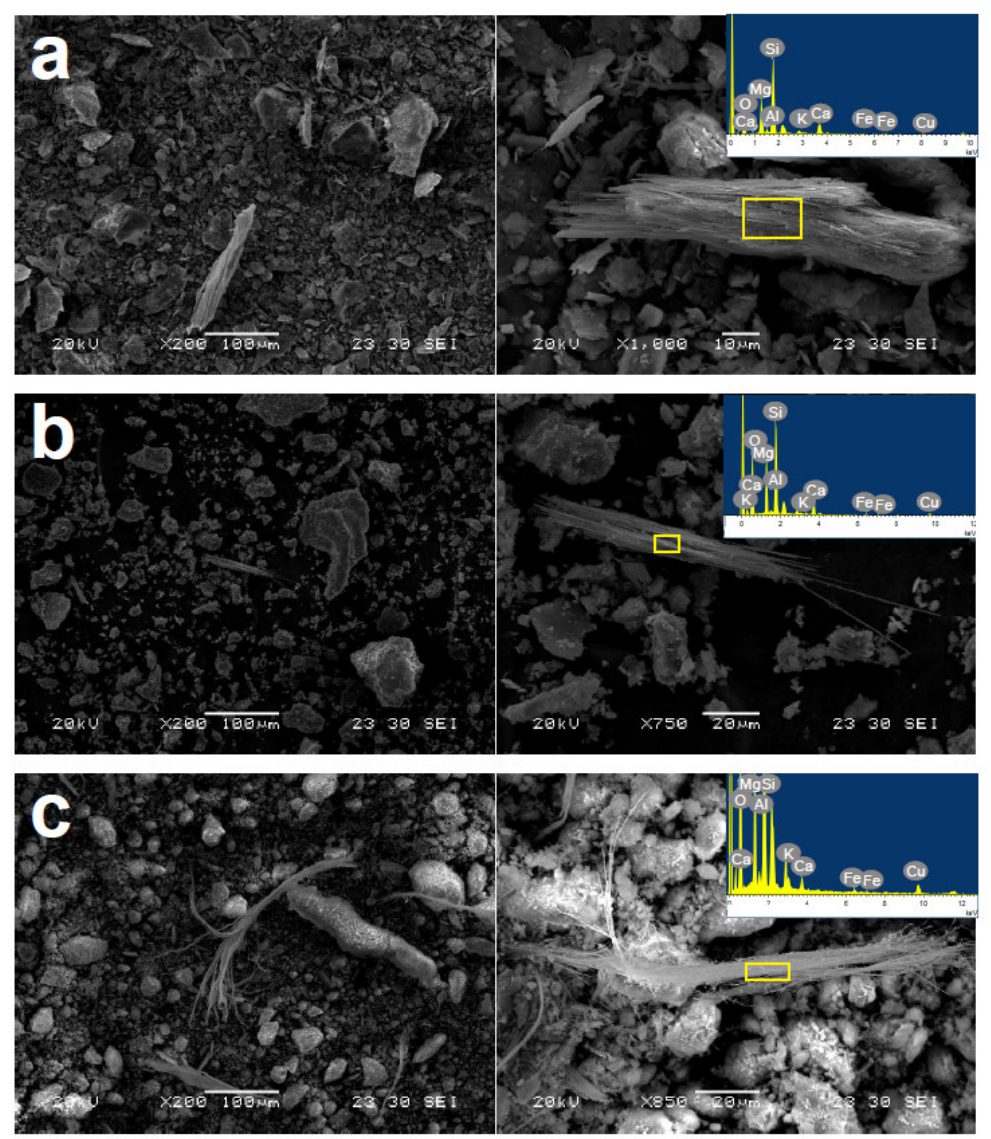
Figure 2. Representative SEM images and EDS spectra of asbestos in a sample with 0.1% ACMs: ( a ) talc, ( b ) vermiculite, and ( c ) sepiolite.